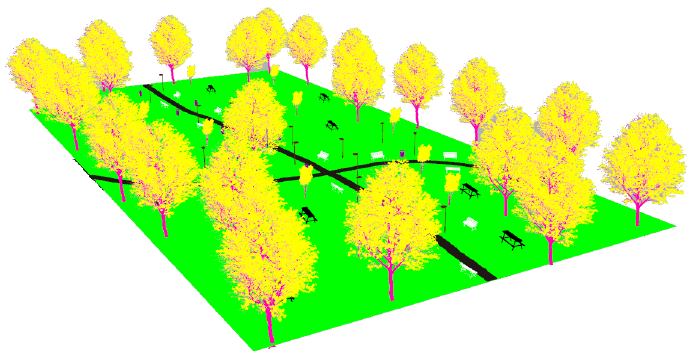
Figure 13. The plain visual model of the park environment.